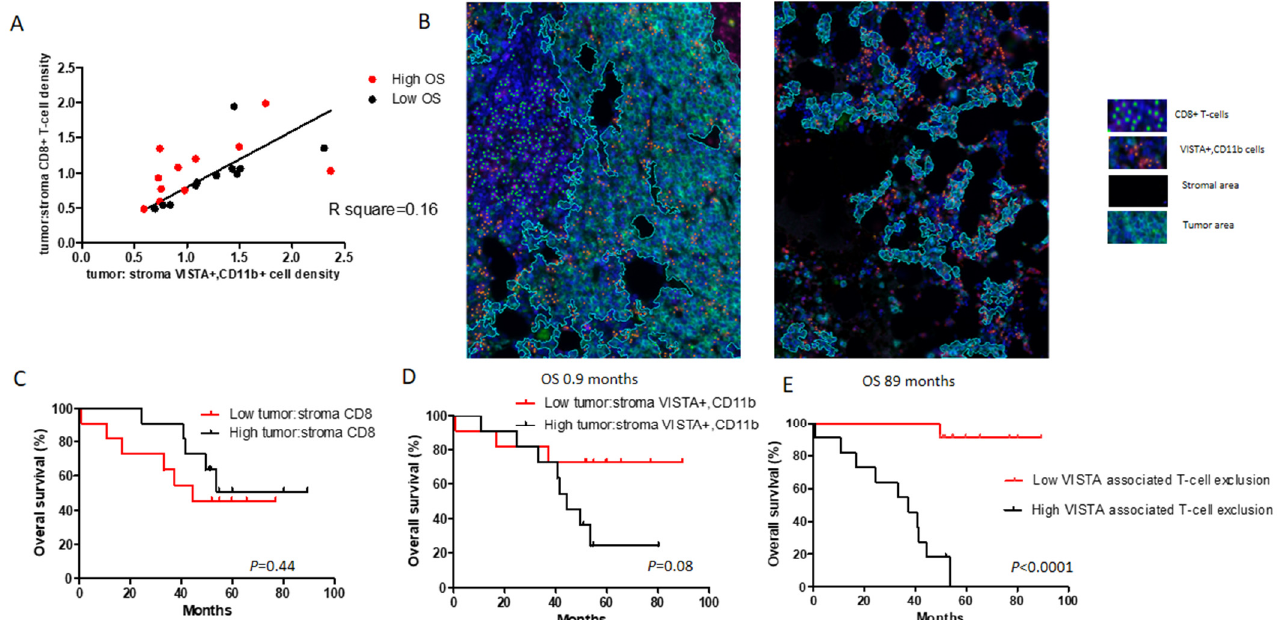
Figure 6. High abundance of VISTA+, CD11b+ cells combined with low abundance of CD8+ T-cells in tumor associates with low OS in MM. ( A ) Correlation plot between preferential CD8 T-cell density and preferential VISTA+, CD11b cell density (see Results for details). ( B ) Immunofluorescence image showing one patient with low OS (0.9 months, left-hand side) and another patient with high OS (89 months, right-hand side). Tumor area is encircled by cyan line. Relative abundance of VISTA+, CD11b+ cells (orange) in tumor area compared to CD8 T-cells (green) associates with low OS, whereas low abundance of VISTA+, CD11b cells in tumor area compared to CD8 T cells is associated with high OS. ( C – E ) Kaplan-Meier estimates showing OS for tumoral abundance of CD8 T-cells ( C ), VISTA+,CD11b+ cells ( D ), and the combination of these two parameters.